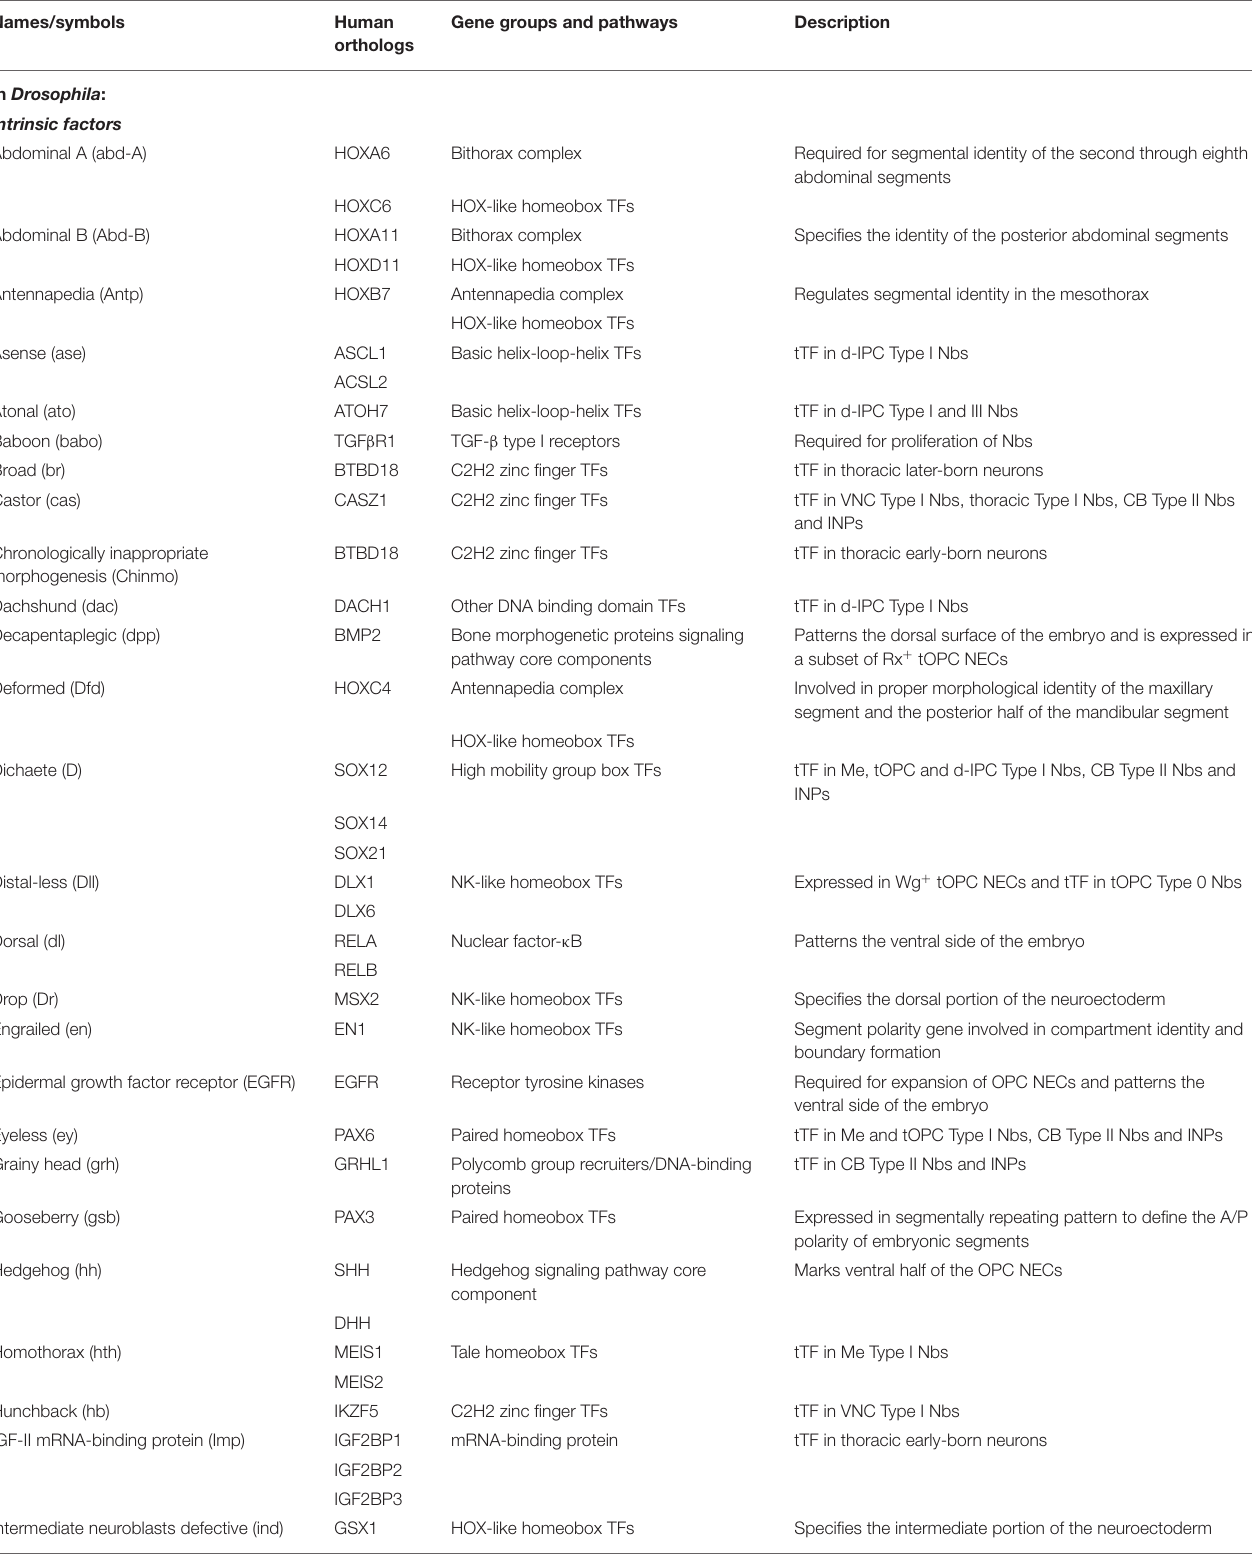
TABLE 1 | Intrinsic factors and glial-derived extrinsic signals influencing cell decisions in Drosophila and mammalian neurogenic niches. Names/symbols Human Gene groups and pathways orthologs